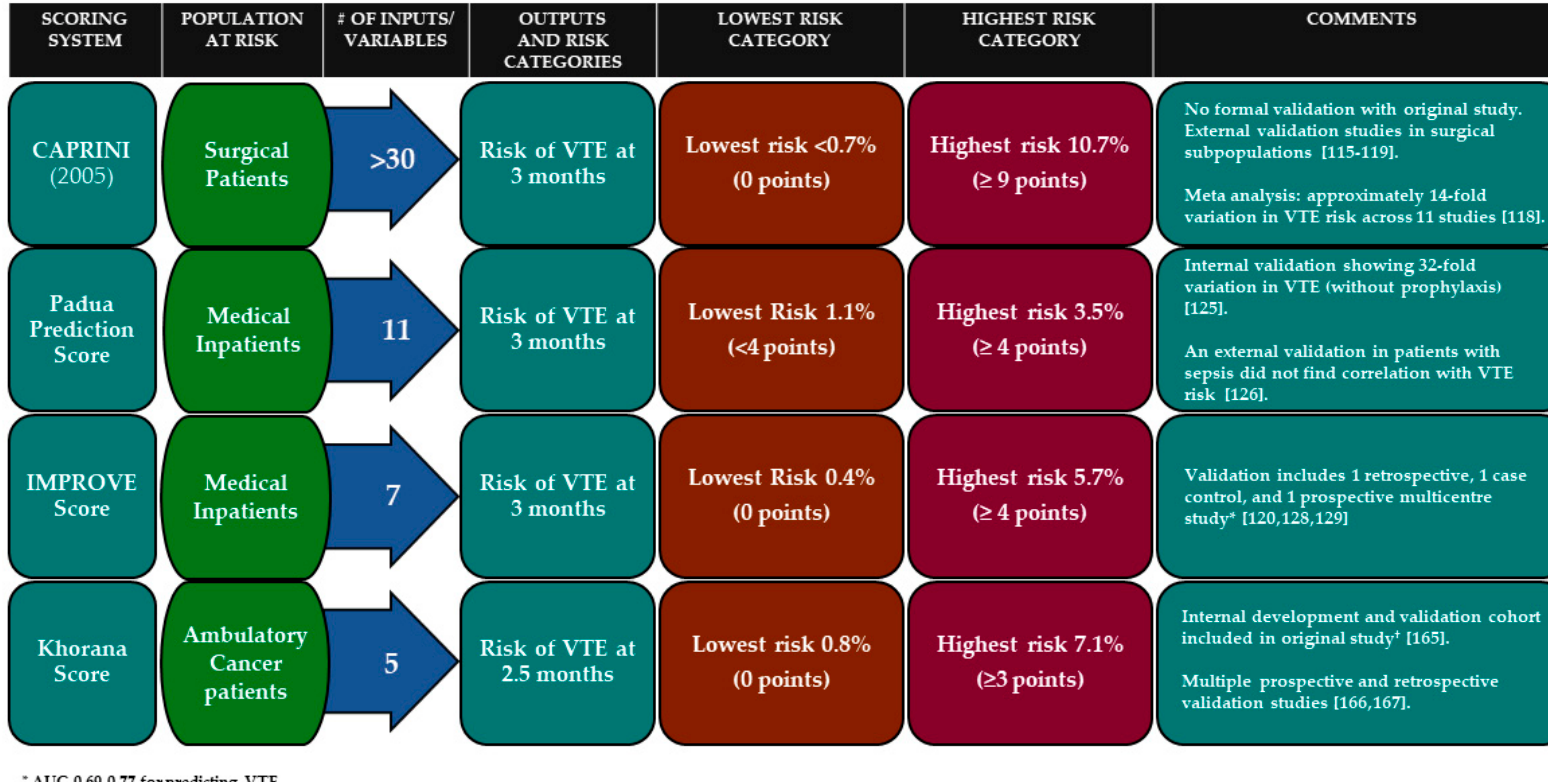
Figure 1. Summary of select scoring systems for predicting risk of venous